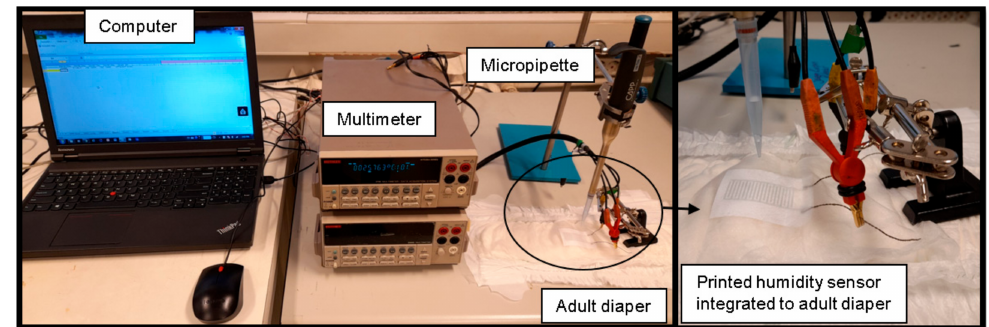
Figure 9. The test setup for urinary incontinence